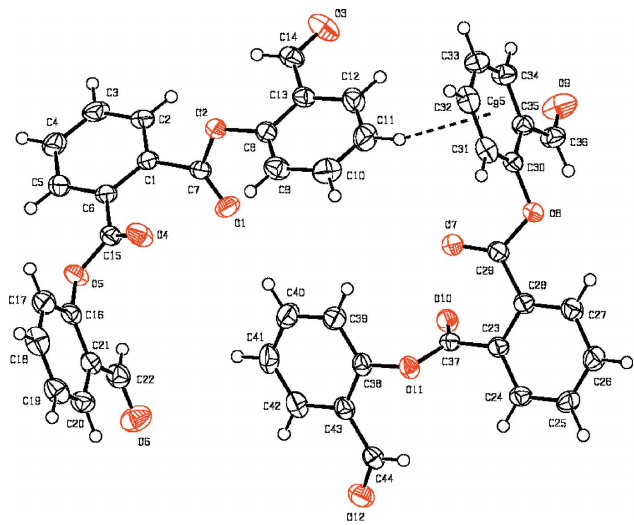
Figure 1 The asymmetric unit of the title compound with labeling scheme and 50% probability ellipsoids. The C—H (cid:3)(cid:3)(cid:3) (cid:2) interaction is shown as a dashed line.